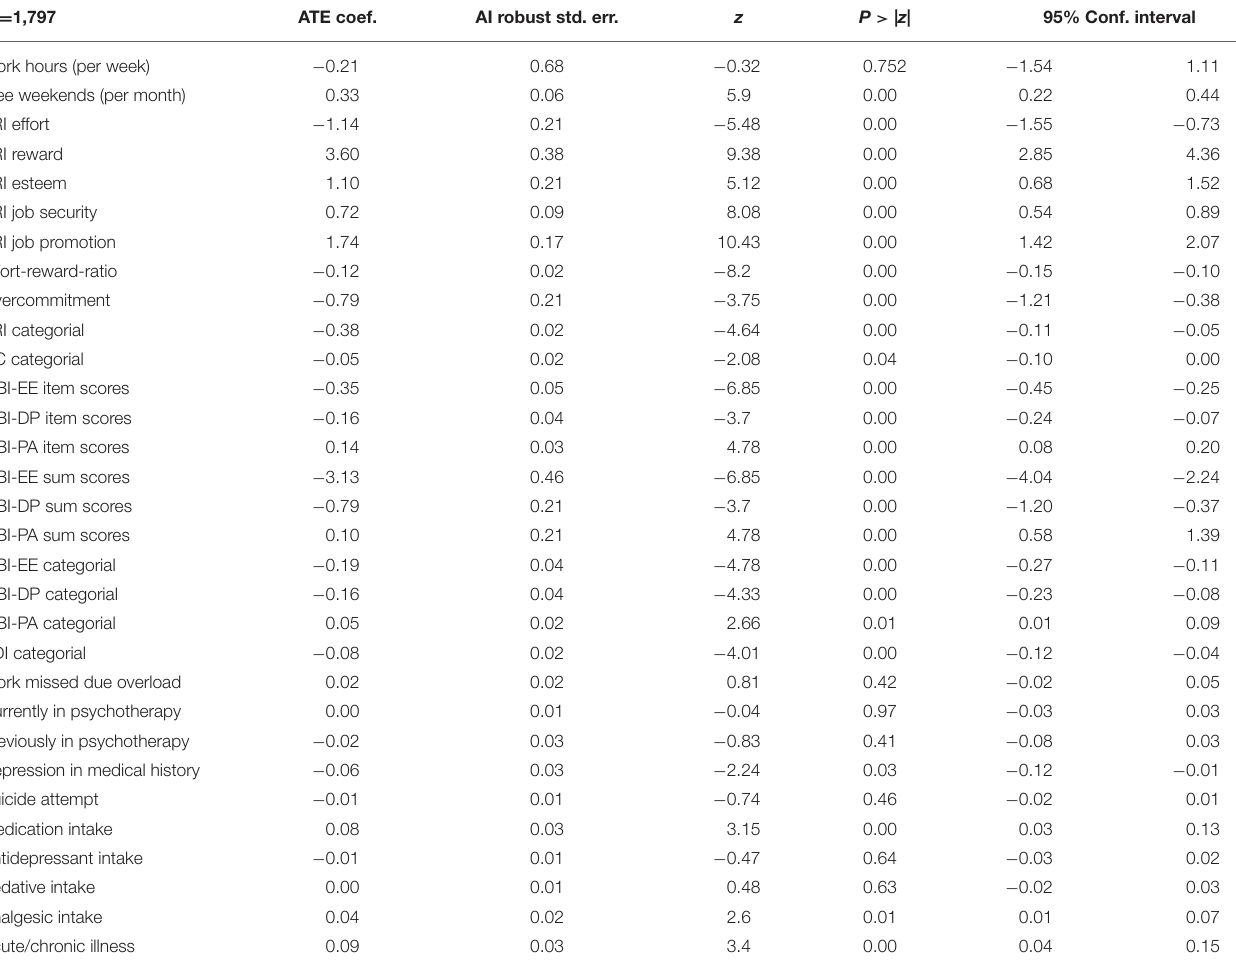
TABLE 2 | Average treatment (year) effect from observational data using logistic models after propensity-score matching (2016 vs. 2006), caliper 0.15. N = 1,797 ATE